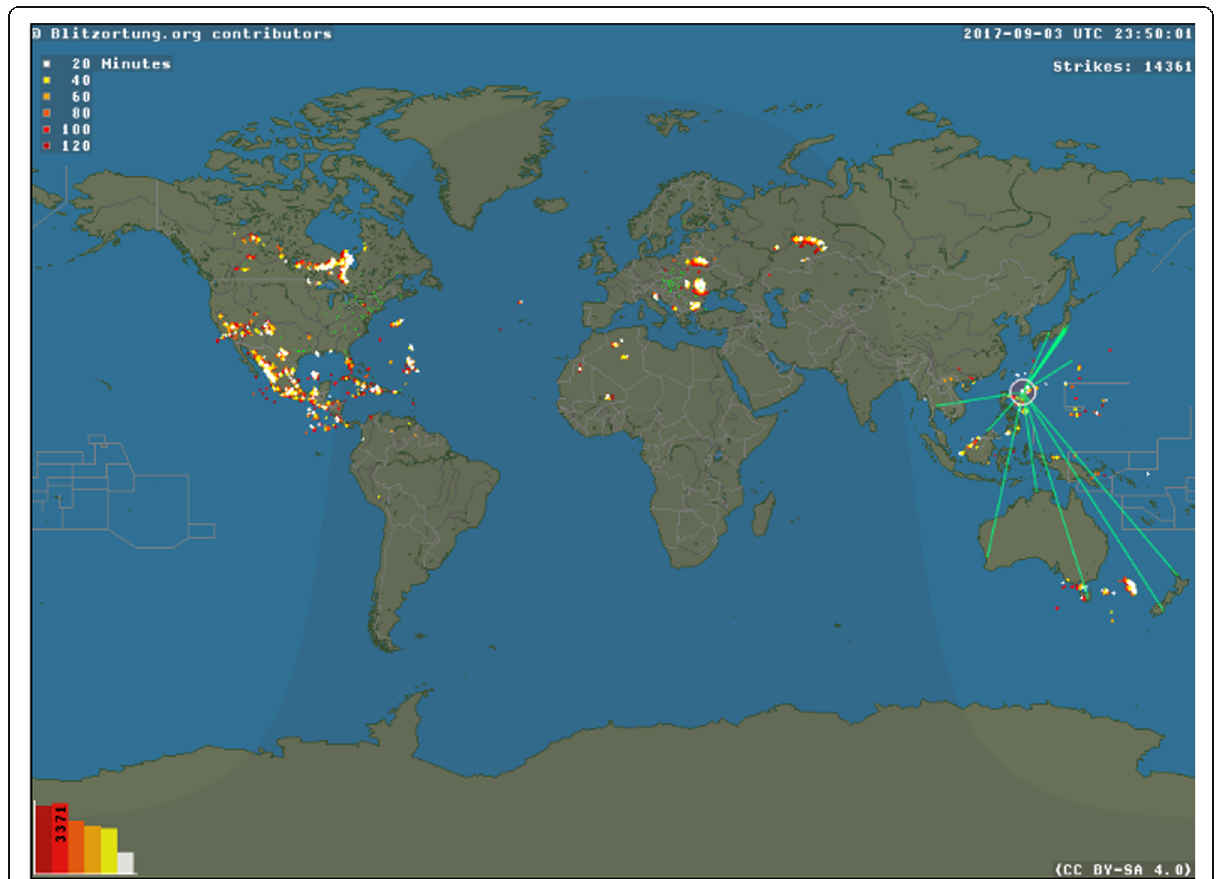
Fig. 4 Map of lightning activity in a 2 h period, detected more or less globally (coverage in South America and Africa by this amateur network is somewhat sparse of stations, which need only a small VLF receiver and an internet connection). A single recent strike is detected (lines) by stations from Japan to Australia and New Zealand, allowing its location in the Philippines — some 8000 km from New Zealand — to be reconstructed (circle) within a second or so. It is also apparent from this plot that there may often exist regions thousands of kilometers across where no lighting is present at a given time. Creative Commons license — by contributors to the Blitzortung